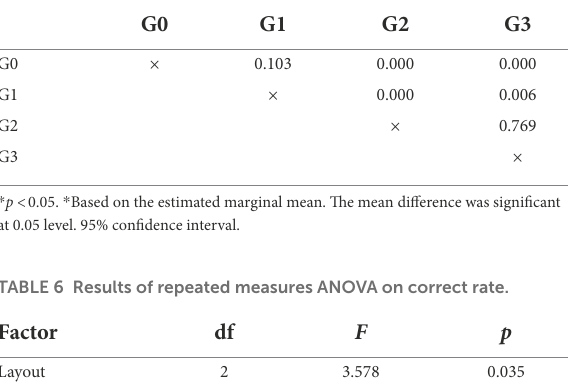
TABLE 5 One-way ANOVA test for different layouts (reaction time).